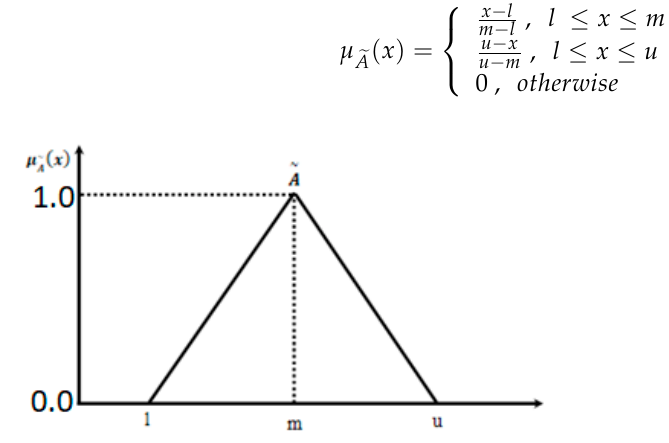
Figure 2. A triangular fuzzy number (TFN), 𝐴(cid:4634) .